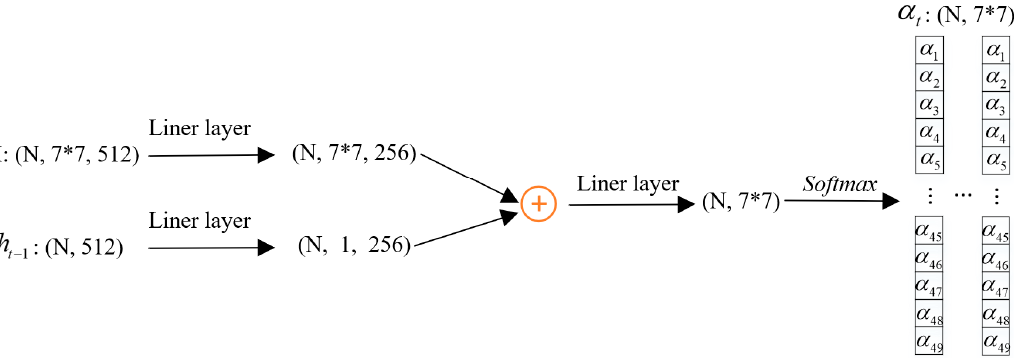
Figure 6. The process of getting attention weights based on Equations (10)–(12). N is batch size.